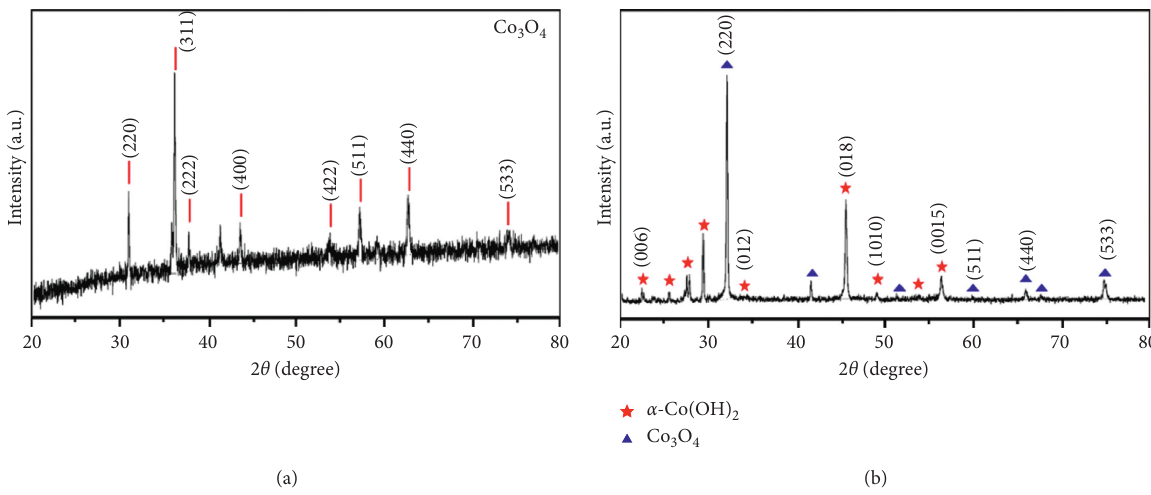
Figure 5: XRD spectra of cobalt oxide nanoparticles obtain from (a) calcination and (b) chemical